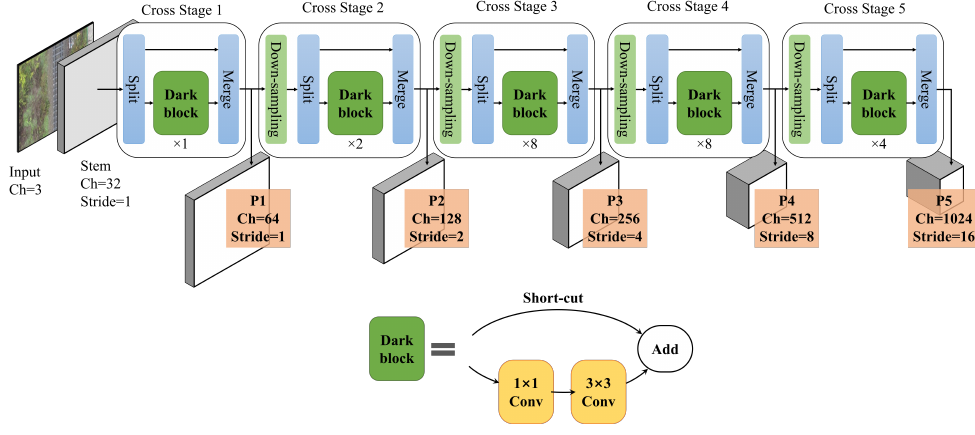
Figure 2. Network structure of